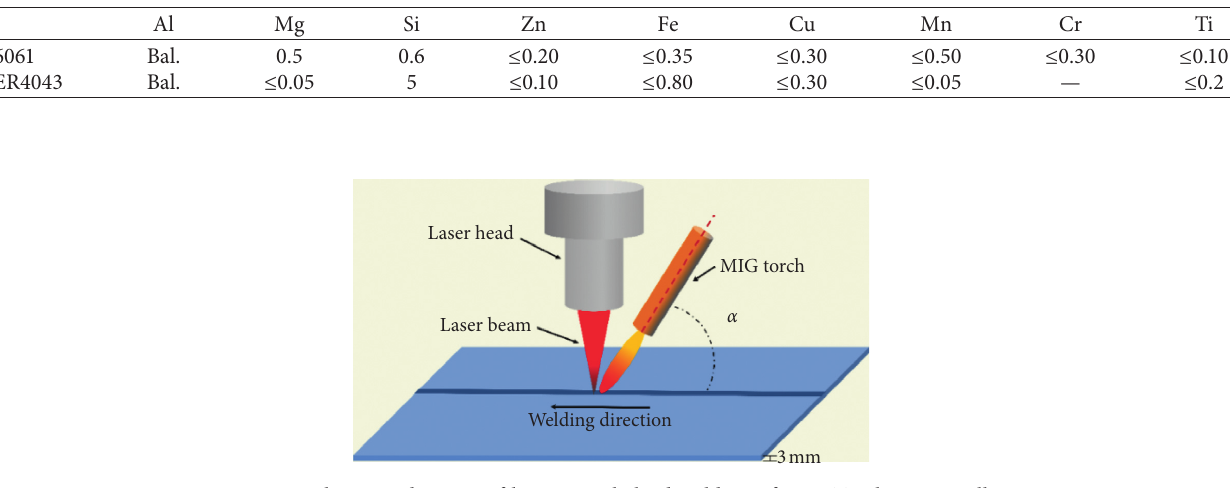
Table 1: Chemical composition of 6061-T6 aluminum alloy and welding wire.